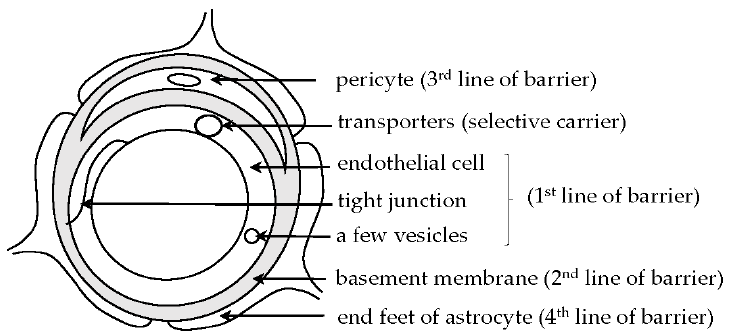
Figure 1. Schematic image of a capillary with the blood–brain barrier is shown. The capillary is composed of endothelial cells with a tight junction and a few vesicles in the cytoplasm (1 st line of barrier), basement membrane (2 nd line of barrier), a pericyte (3 rd line of barrier), and end feet of astrocytes (4 th line of barrier), contributing to barrier function of cerebral microvessels. The localization of transporters, contributing to selective carrier function of the vessels, is conceptually shown in the endothelial cell.